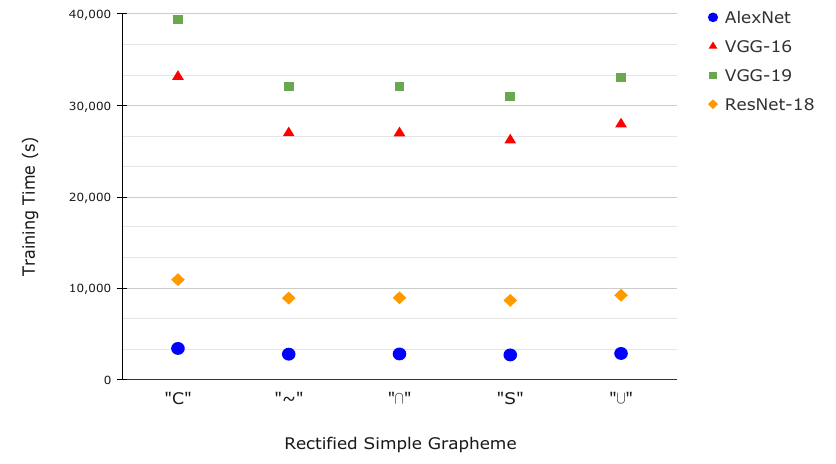
Figure 8. Rectified Simple Grapheme Training time of AlexNet, VGG-16/VGG-19 and ResNet-18